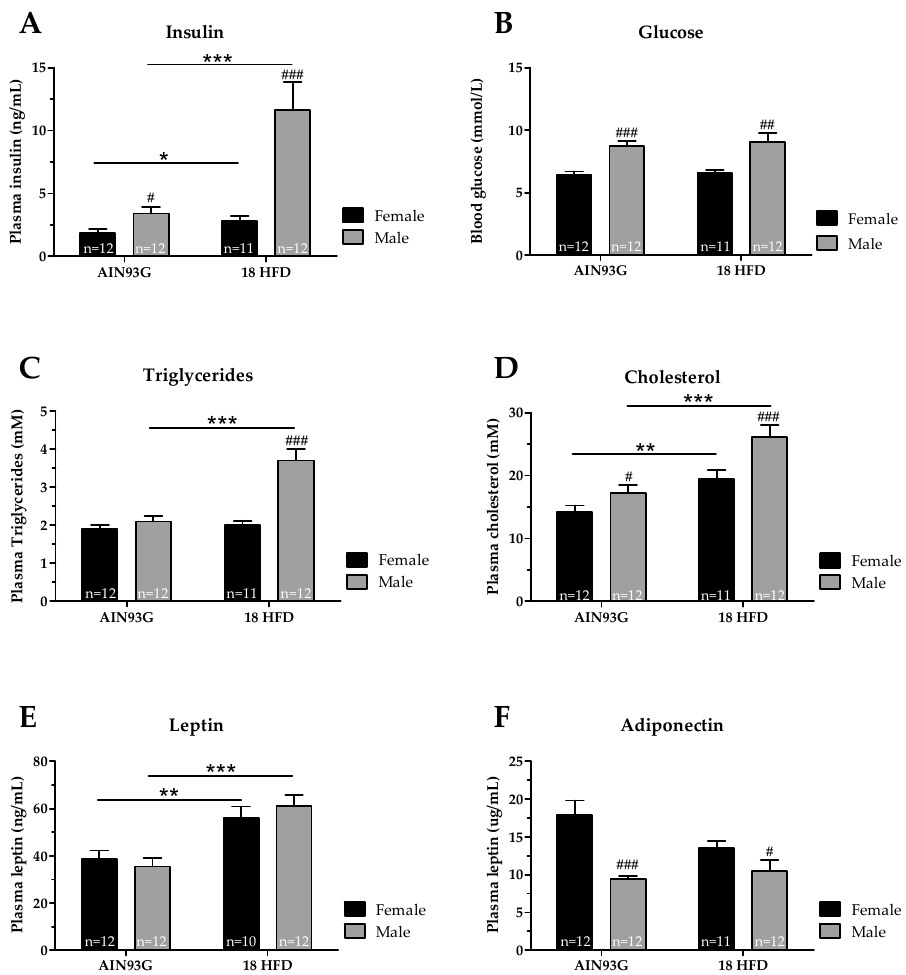
Figure 3. Circulating levels of metabolic risk markers in Ldlr- / -.Leiden mice after 18 weeks of AIN93G diet or HFD feeding. Five-hour fasted levels of ( A ) insulin, ( B ) glucose, ( C ) triglycerides, ( D ) cholesterol, ( E ) leptin and ( F ) adiponectin. * p ≤ 0.050, ** p ≤ 0.01 and *** p ≤ 0.001 significant dietary effect. # p ≤ 0.050, ## p ≤ 0.010 and ### p ≤ 0.001 significant effect in sex.